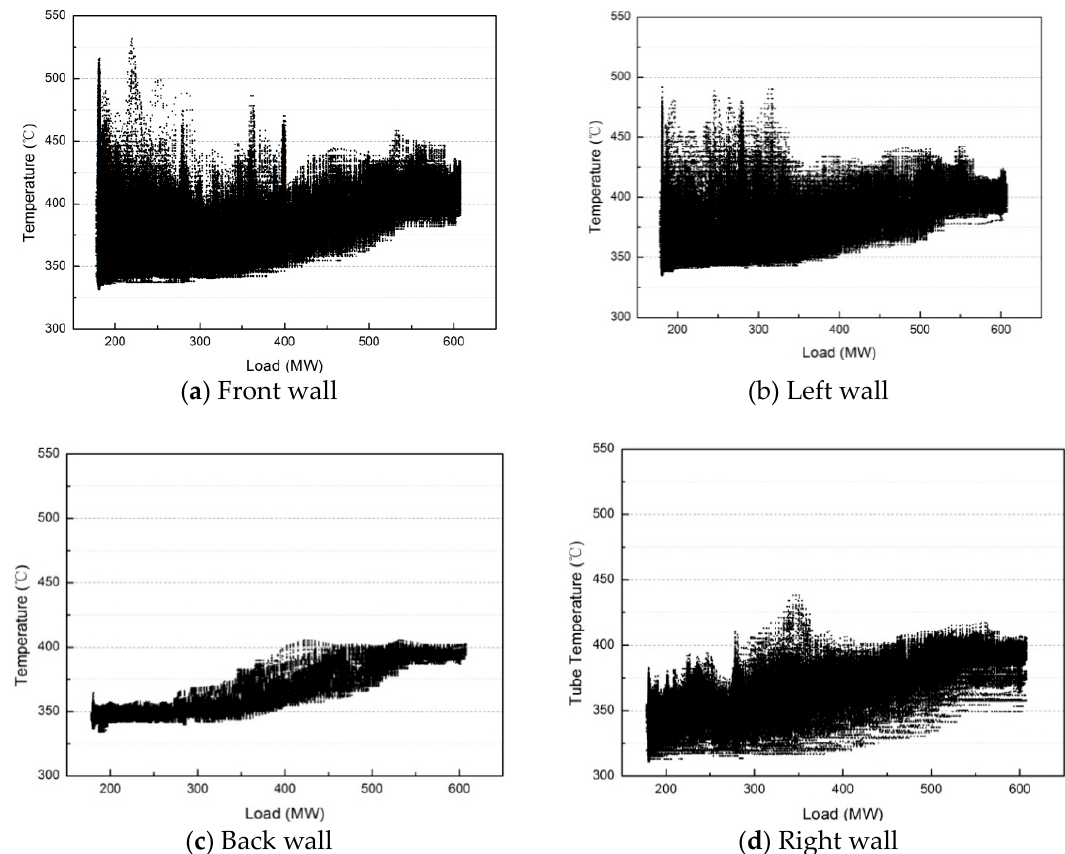
Figure 5. Tube temperature distributions at the front, left, back, and right vertical water walls.